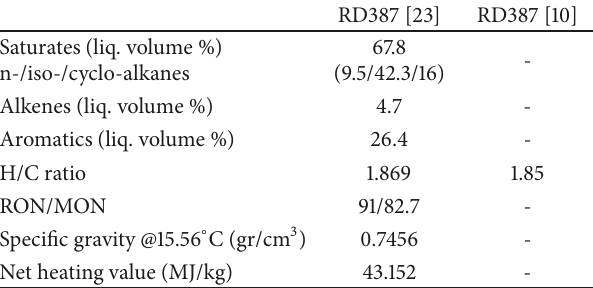
Table 8: RD387 physical and chemical